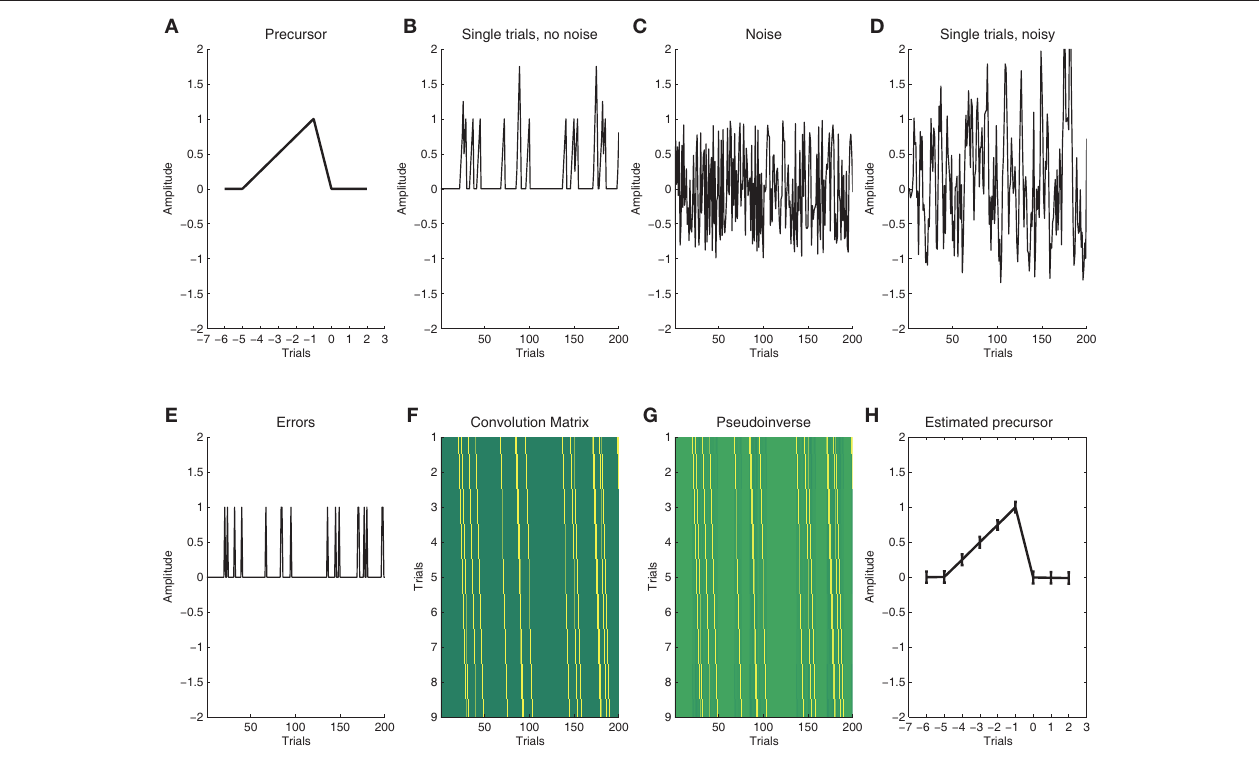
FiGurE 1 | illustration of deconvolution of latent sequential effects. (A) We assume a latent precursor signal that gradually evolves across trials and precedes each error; (B) In order to illustrate a noiseless sequence of single trials we convolve a vector with 10% errors at random instances, note the summation of overlapping sequences; (C) for real data, we assume additional noise; (D) Convolution of the noisy data (C + E ) with (A) yields the simulated single-trial data